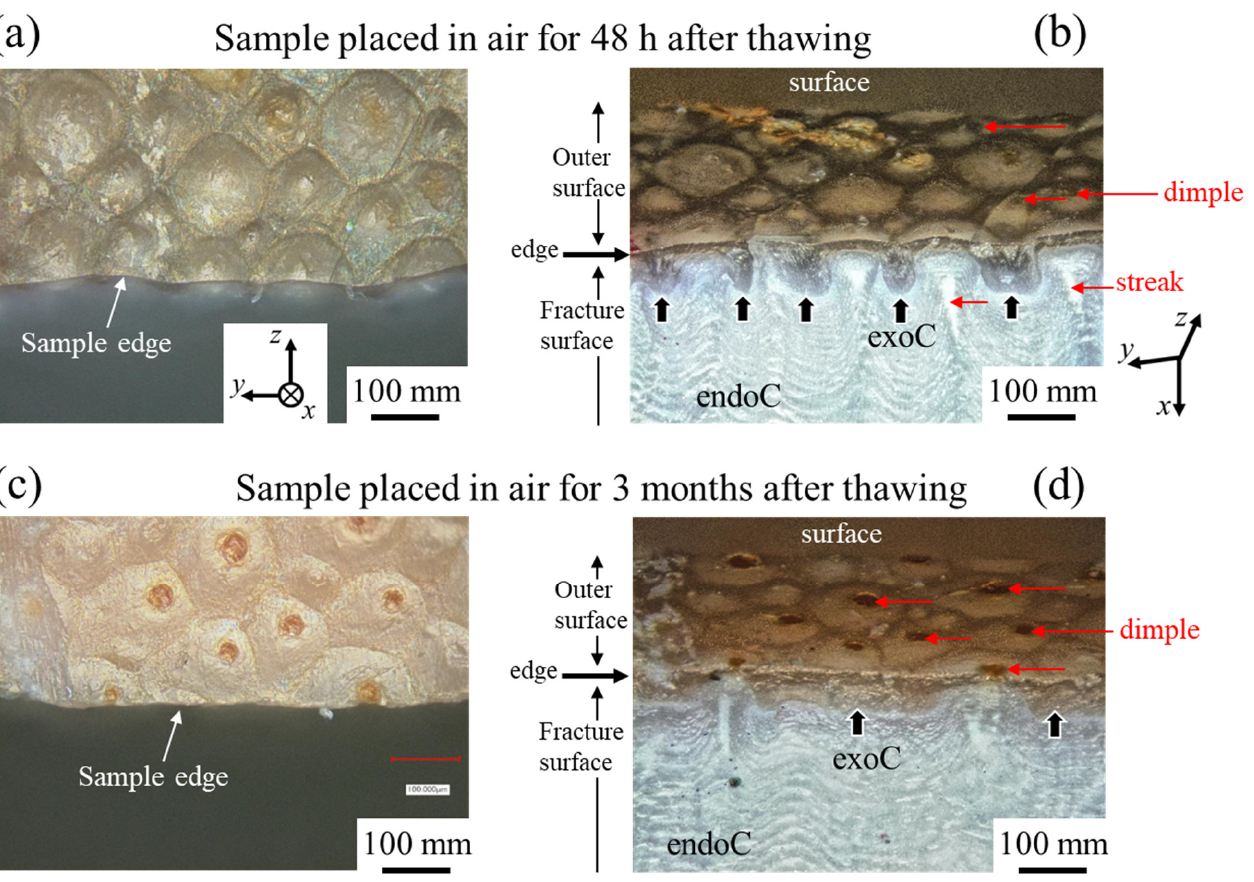
Figure 4. ( a , c ) Optical micrographs of the surface of the mottled, deep-blue area of two samples placed in air for 48 h and 3 months after thawing, respectively, and ( b , d ) high-dynamic range (HDR) images taken with the sample tilted slightly.